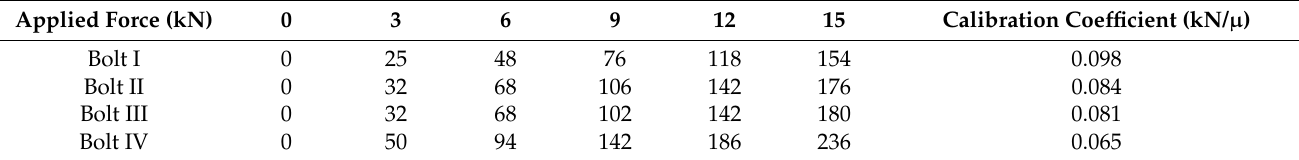
Figure 7. High-strength bolts connections with strain gauges. Table 1. Calibration parameters of high-strength bolts.